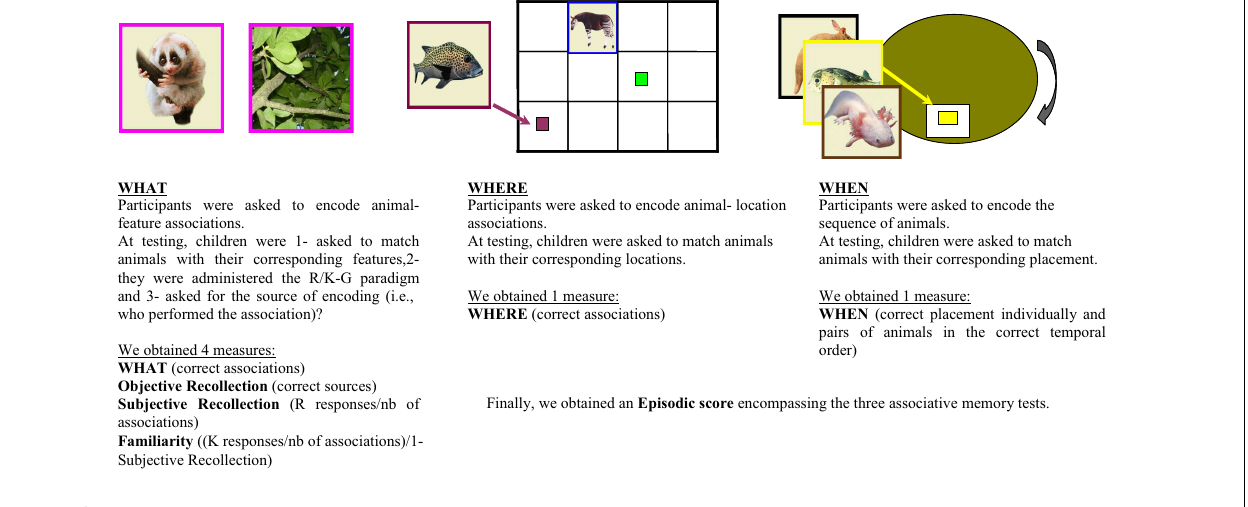
FIGURE 1 | «WHAT-WHERE-WHEN»paradigm